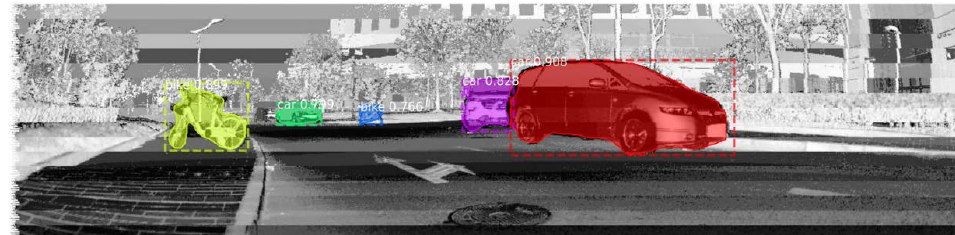
Figure 26. The 2D segmentation results from Mask RCNN of the outdoor scene.